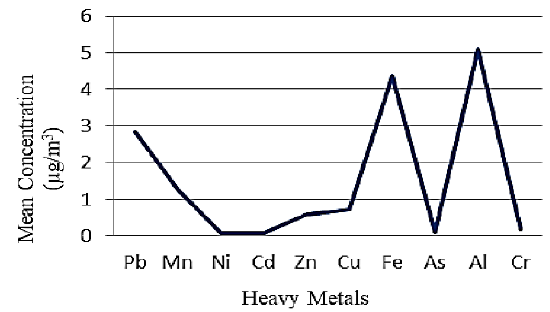
Fig. 3. Mean concentrations of heavy metals in outdoor stations